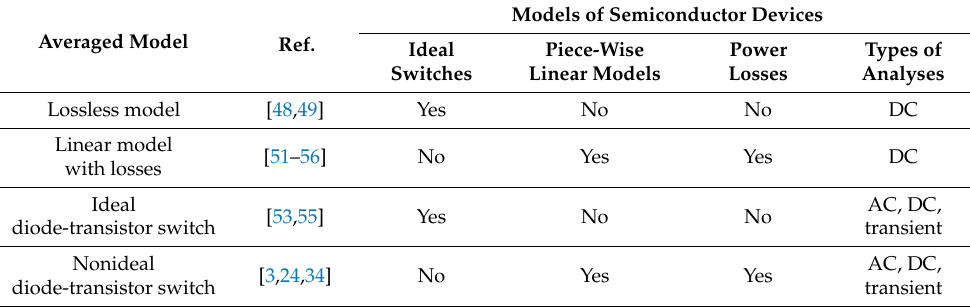
Table 2. Properties of the isothermal averaged models. Averaged Model Ref.